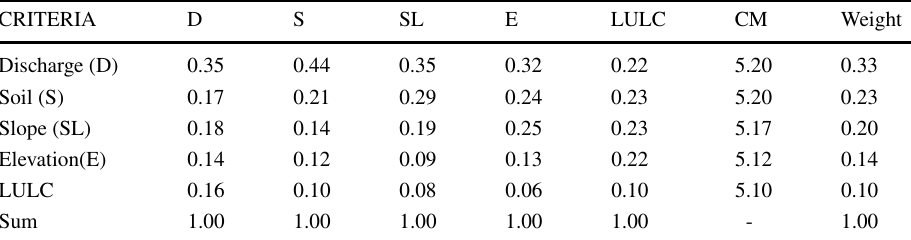
Table 8 Matrix normalization with the weights and consistency measure (CM)